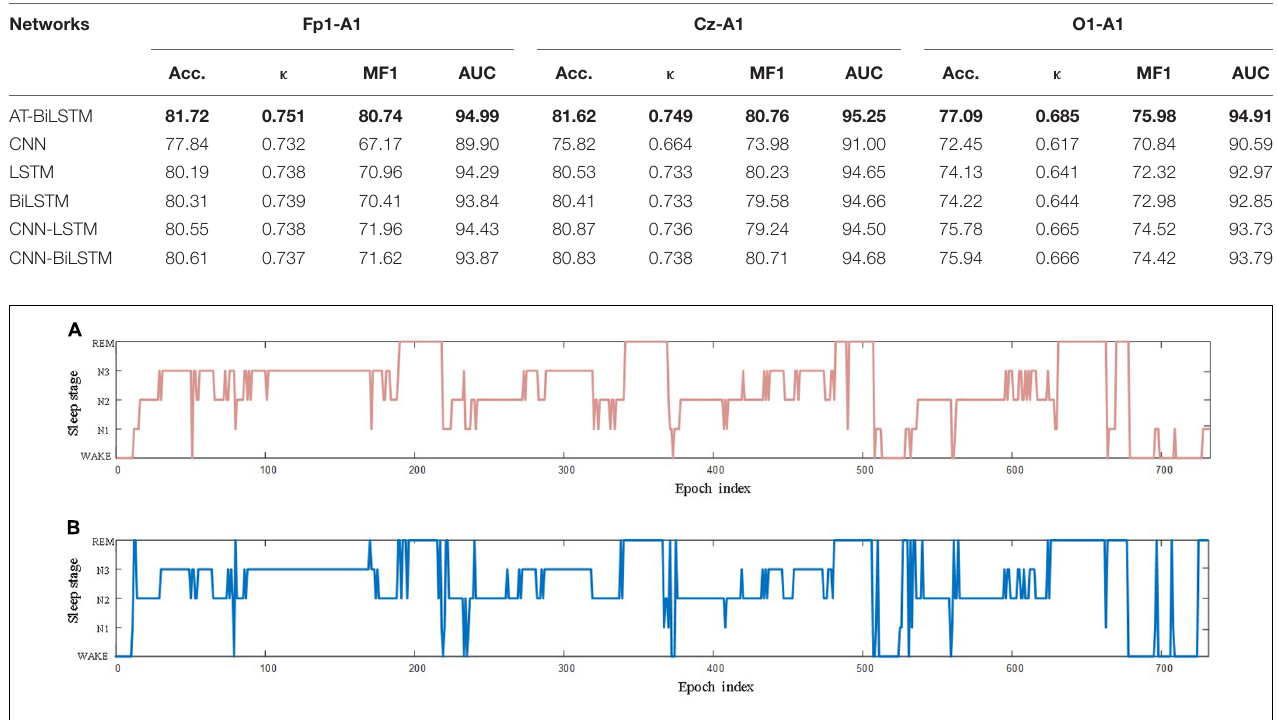
TABLE 4 | The overall performance of different networks on the DRM-SUB dataset (value in bold represents for the best among all the networks). Networks Fp1-A1 Cz-A1 O1-A1 Acc. AT-BiLSTM